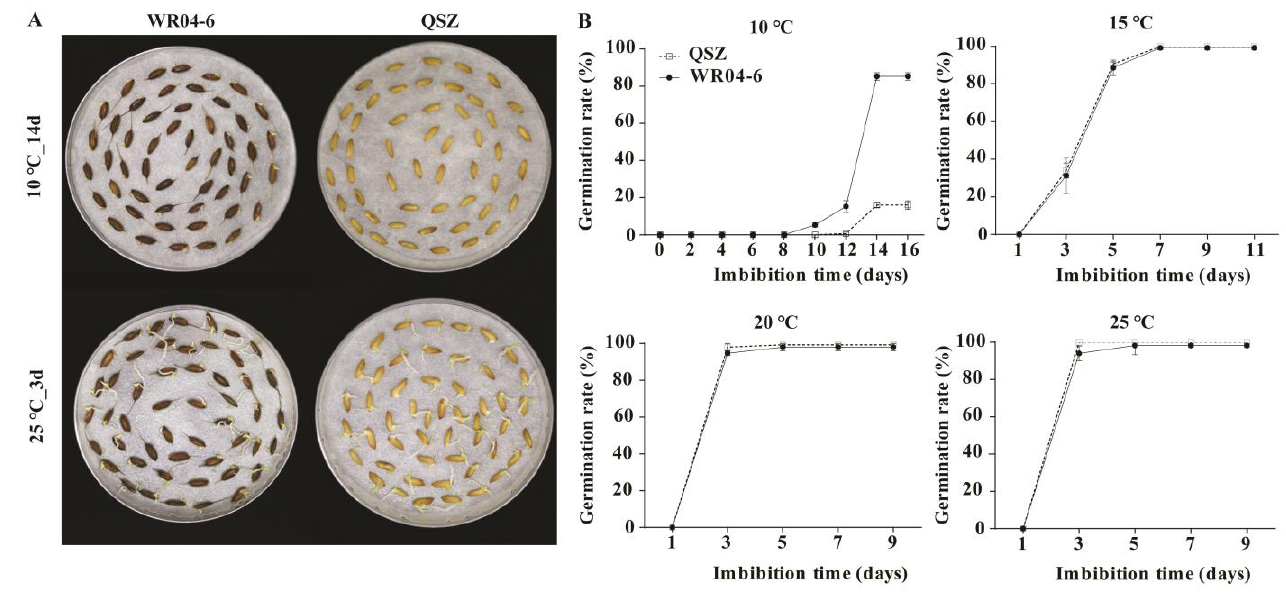
(Table S1). Clean reeds were mapped onto the rice genome https://phytozome.jgi.doe.